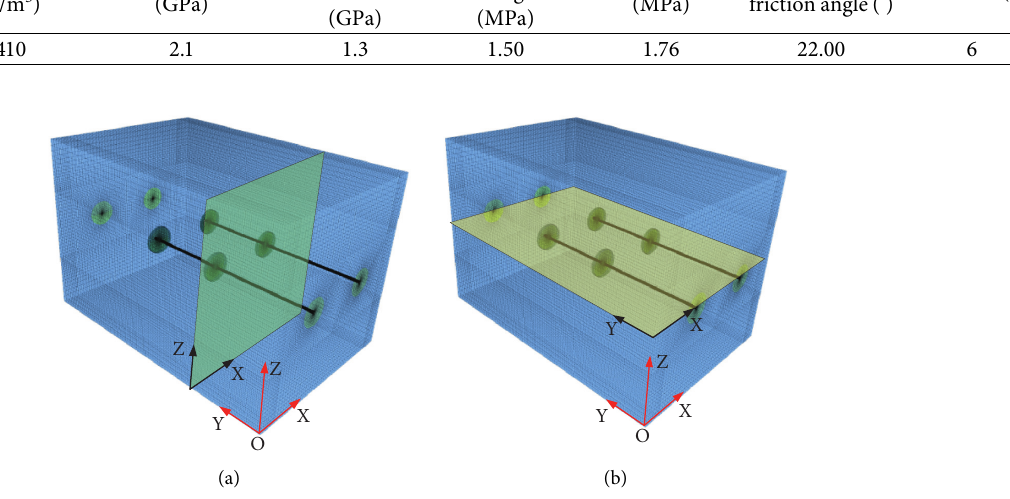
Figure 14: Schematic diagram of the observation sections. (a) Section 1. (b) Section